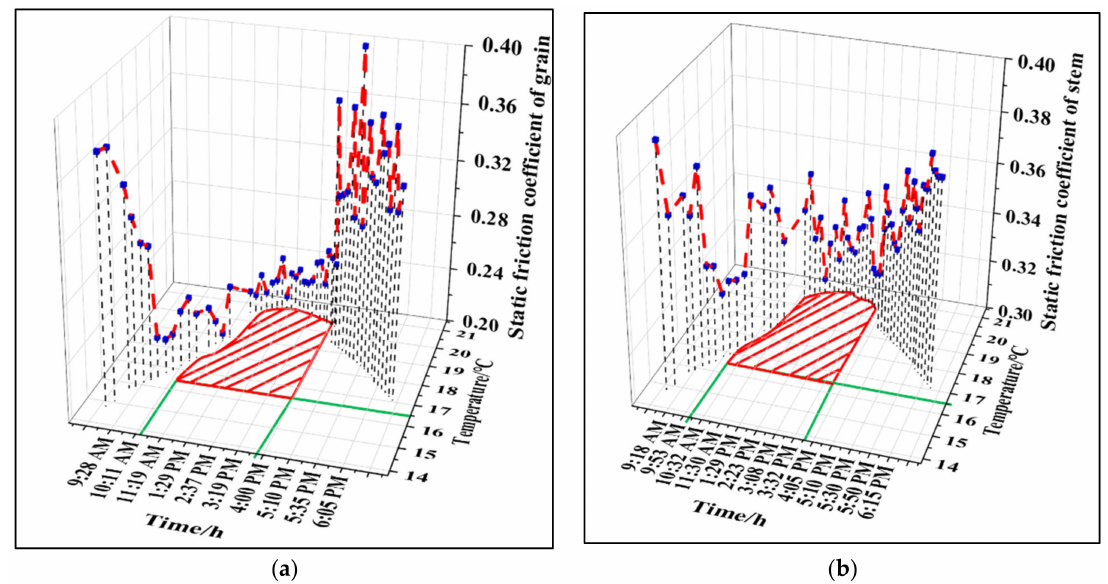
Figure 8. Average static friction coefficients of the rice grains and stems for different measurement periods (harvest time) and temperatures: ( a ) rice grain; ( b ) rice